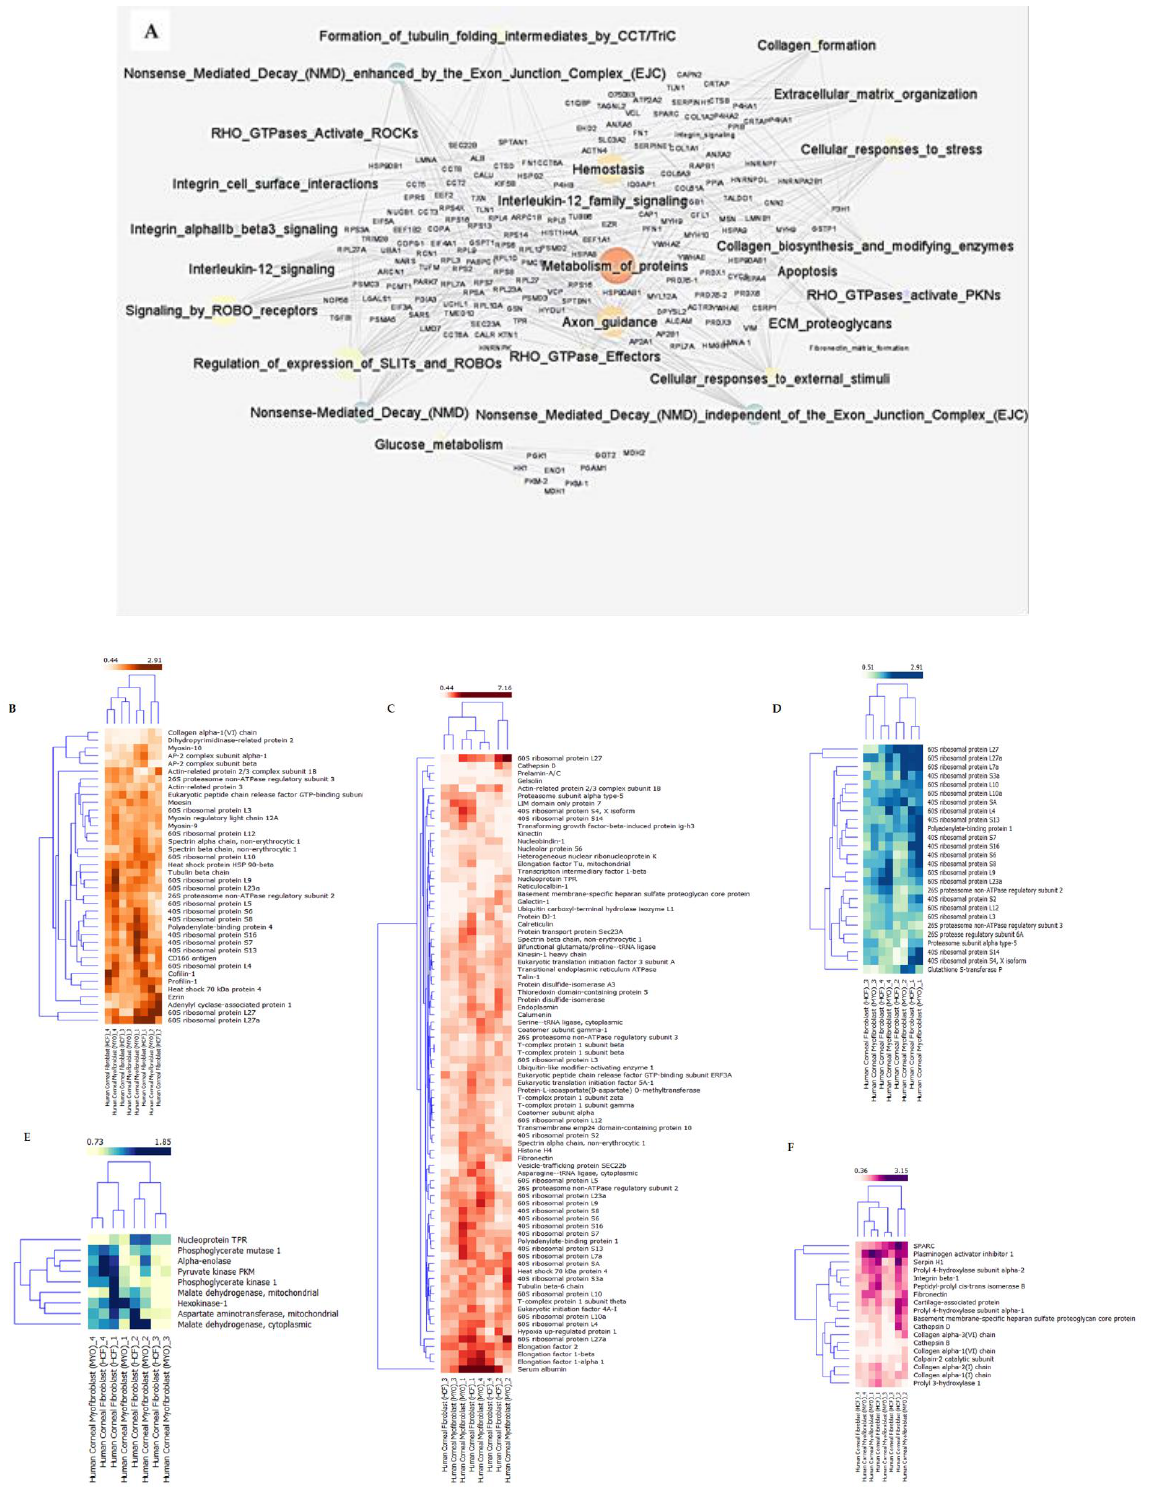
Figure 4. Edge-betweenness-centrality-based network visualization of protein and pathway inter- actions and hierarchical clustering of highest-degree pathways. ( A ) Interactome map illustrating interaction of important pathways with the proteins based on the edge-betweenness parameters. Metabolism of proteins showed high edge-betweenness with TPR, P4B, FN1, HSPG2; axon guidance interactions showed the lowest number of shortest paths interacting primarily with MSN protein in a network, whereas glucose metabolism interactions showed the maximum number of shortest paths in a network. Regulation of expression of SLITs and ROBOs showed high edge-betweenness in